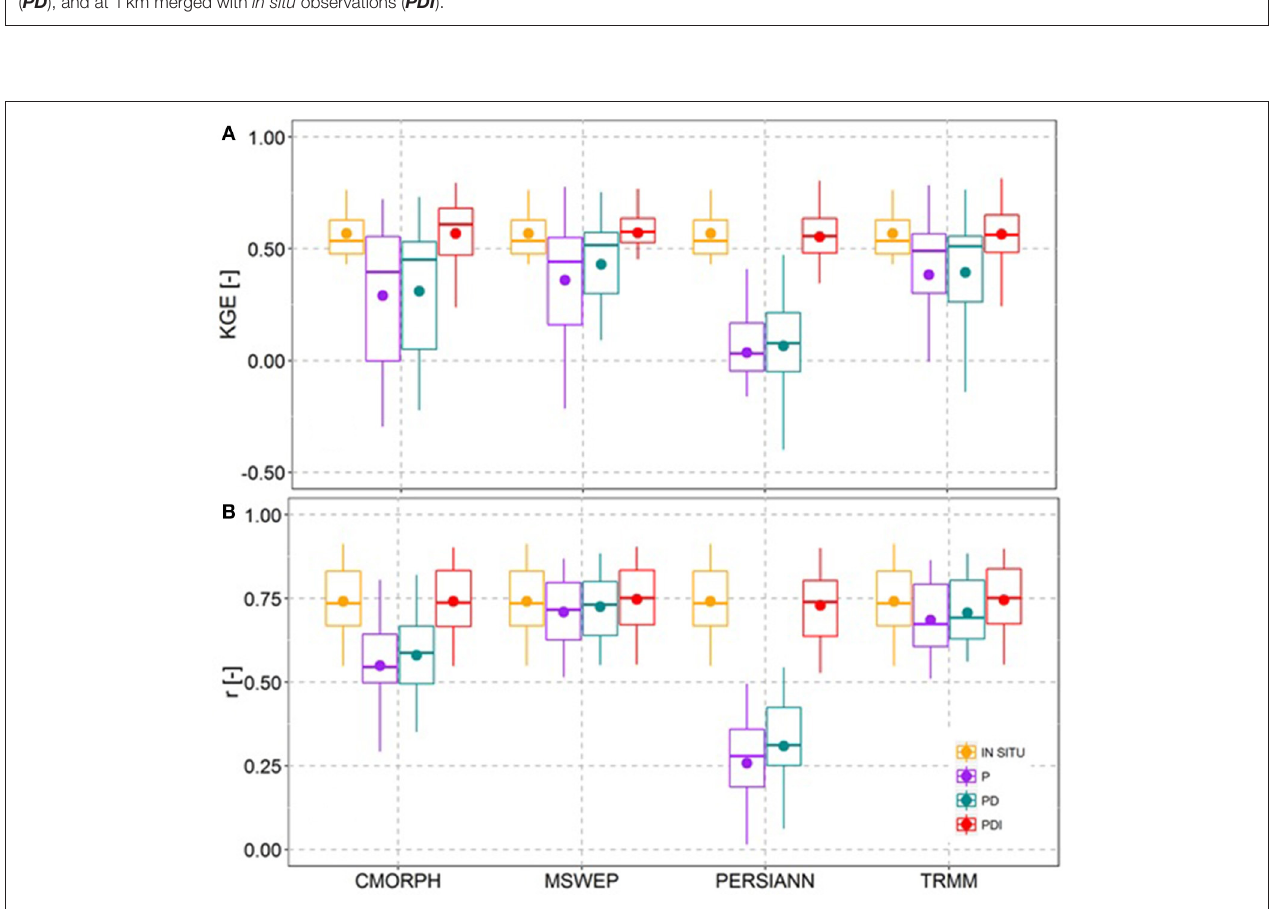
FIGURE 8 | (A) KGE and (B) r values between daily simulated and observed discharge at the 22 discharge stations when the model was forced with in situ precipitation data (orange) and satellite-based precipitation datasets at 25km ( P , purple), at 1km ( PD , blue), and at 1km merged with in situ observations ( PDI , red) for the 2000–2012